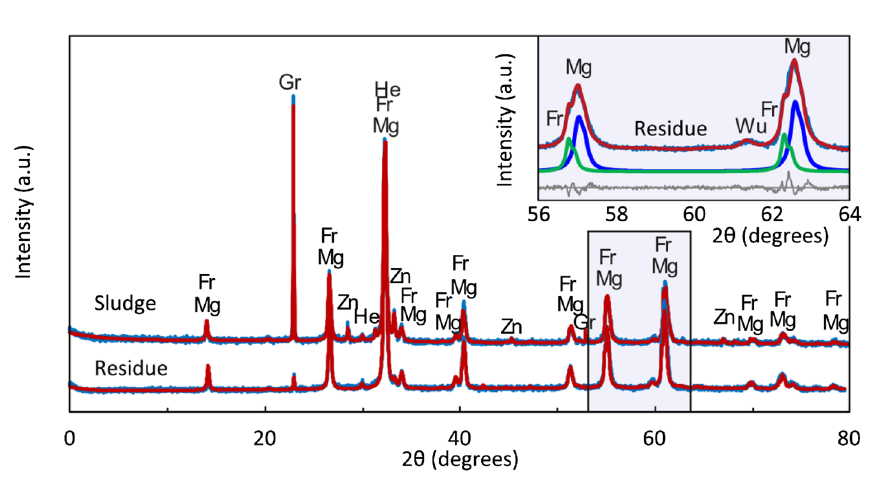
Figure 4. XRD patterns of the original sludge and the solid residue obtained by leaching in 0.01 M CH 3 COOH. Blue—magnetite, red—summary model, thin blue coinciding with red—measurement, grey—difference between the measurement and model. Green in the